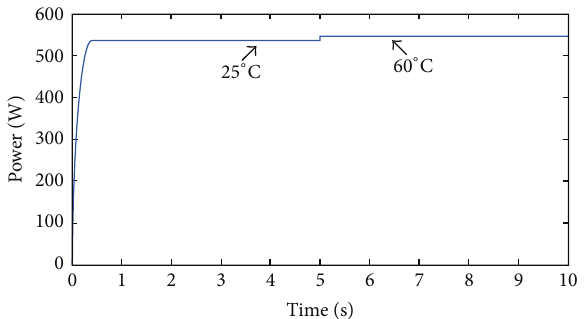
Figure 9: FC output response given step change in membrane water